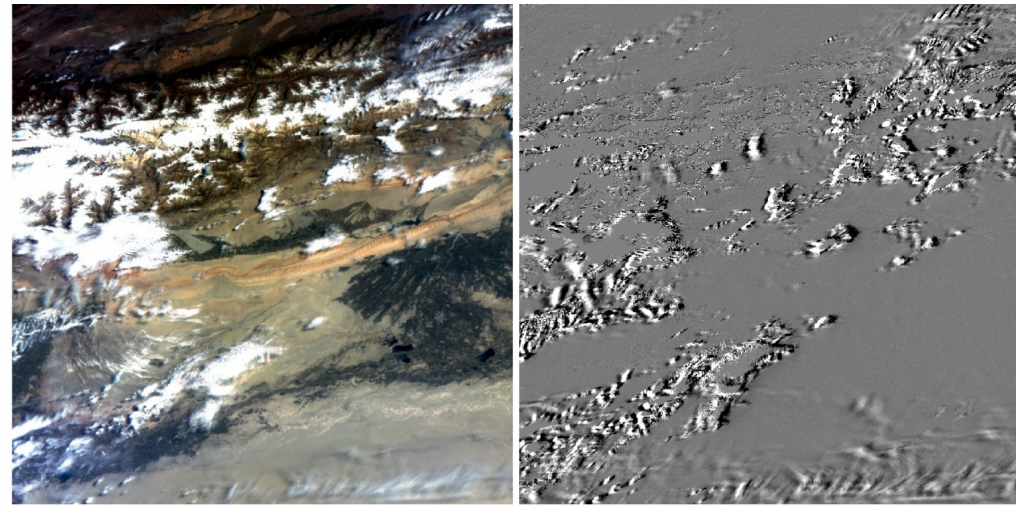
Figure 9. False-color GF-4 image of the Xinjiang area using the NIR-R-G composition (left) and a di ff erence map of two time-adjacent blue band images of the same area (right).